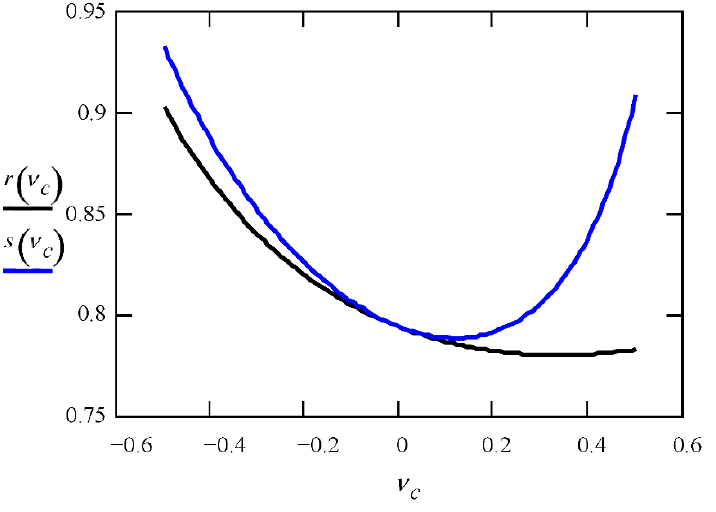
Figure 2. Comparison of Allen’s solution in the case of the plane stress ( r ) and plane strain ( s ) states. It should come as no surprise that for v C = 0, the coefficients r and s are identical and equal to 0.794. For negative values of v C , the coefficients r and s take similar values that are much higher than 0.794. For v C tending to − 1, the values of r and s , and hence the critical stress values, tend to infinity. In the range of v C ( − 1; +0.5), the critical stresses in the